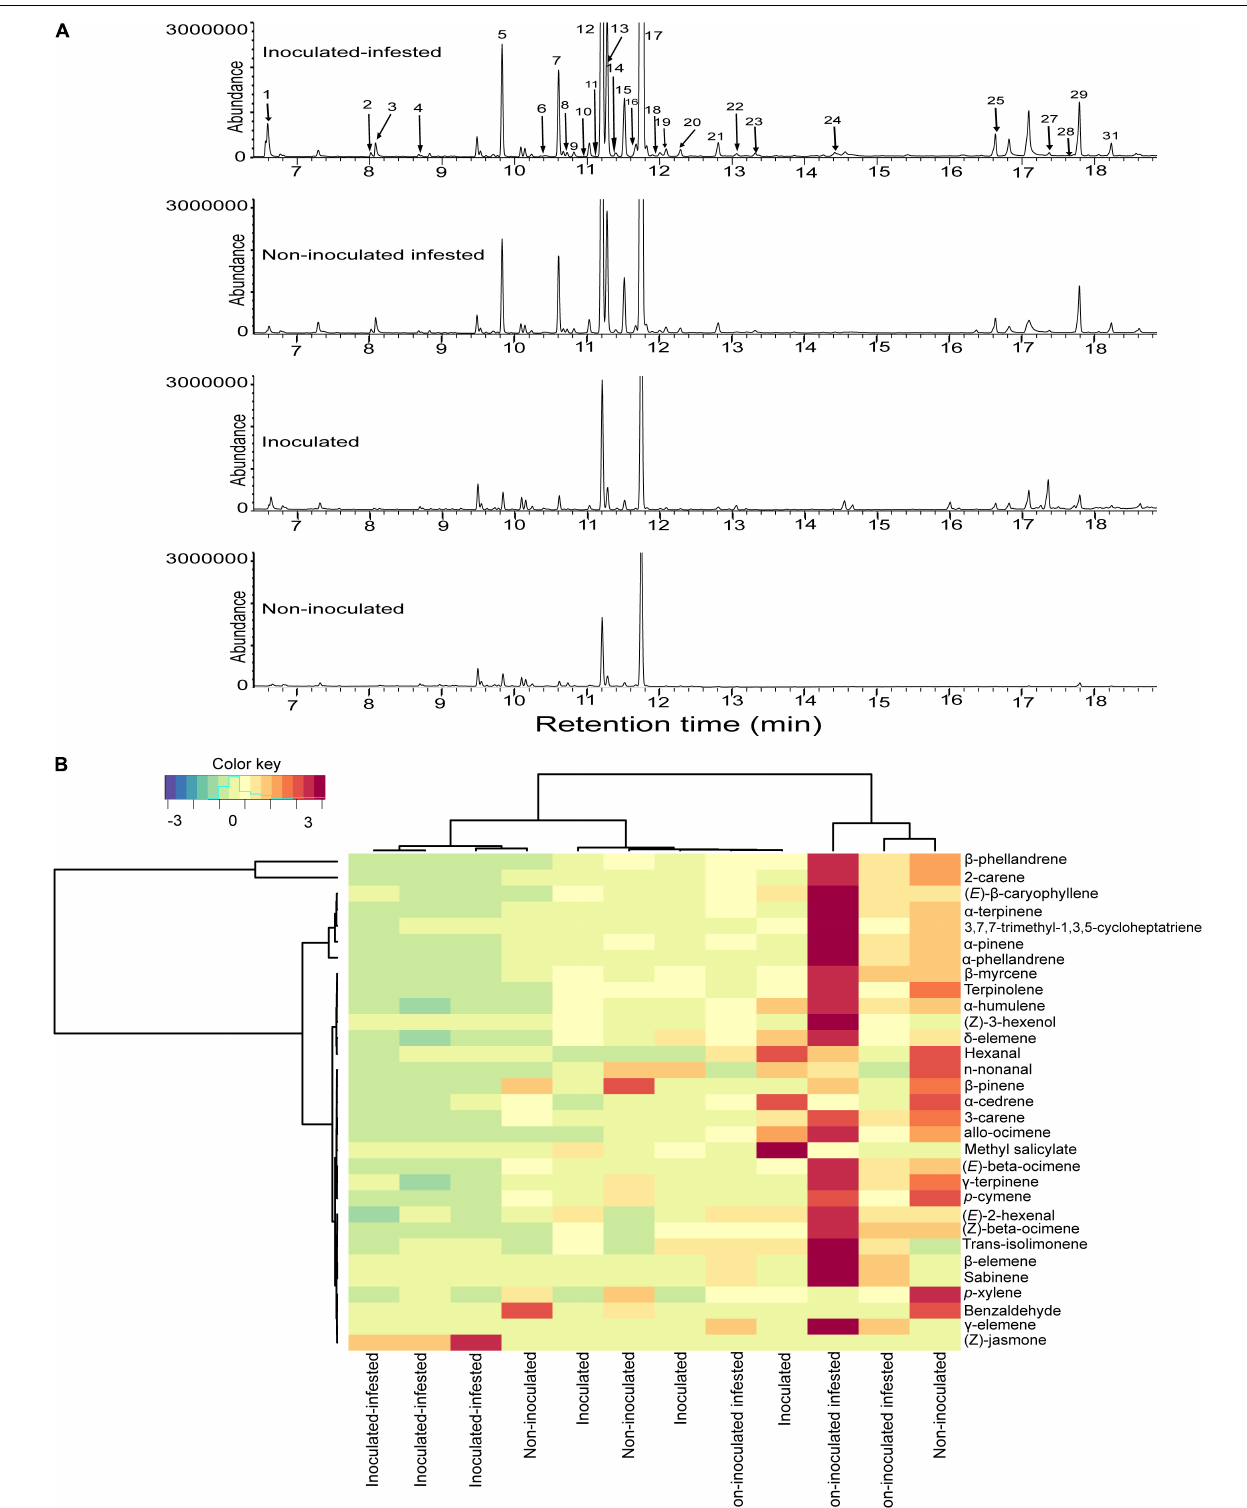
FIGURE 3 | Variations in volatile organic compounds across non-inoculated, inoculated, non-inoculated infested, and inoculated infested tomato plants. (A) Representative total ion chromatogram of non-inoculated, inoculated, non-inoculated infested, and inoculated infested tomato plants. (B) Heatmap clustering showing the abundance (in decreasing color intensity) of the volatile compounds across replicates of the four treatments.